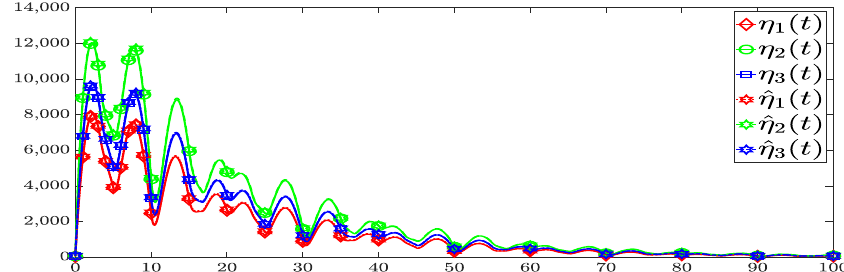
Figure 4. The state trajectories of system (1) with input u (cid:48) ( t )